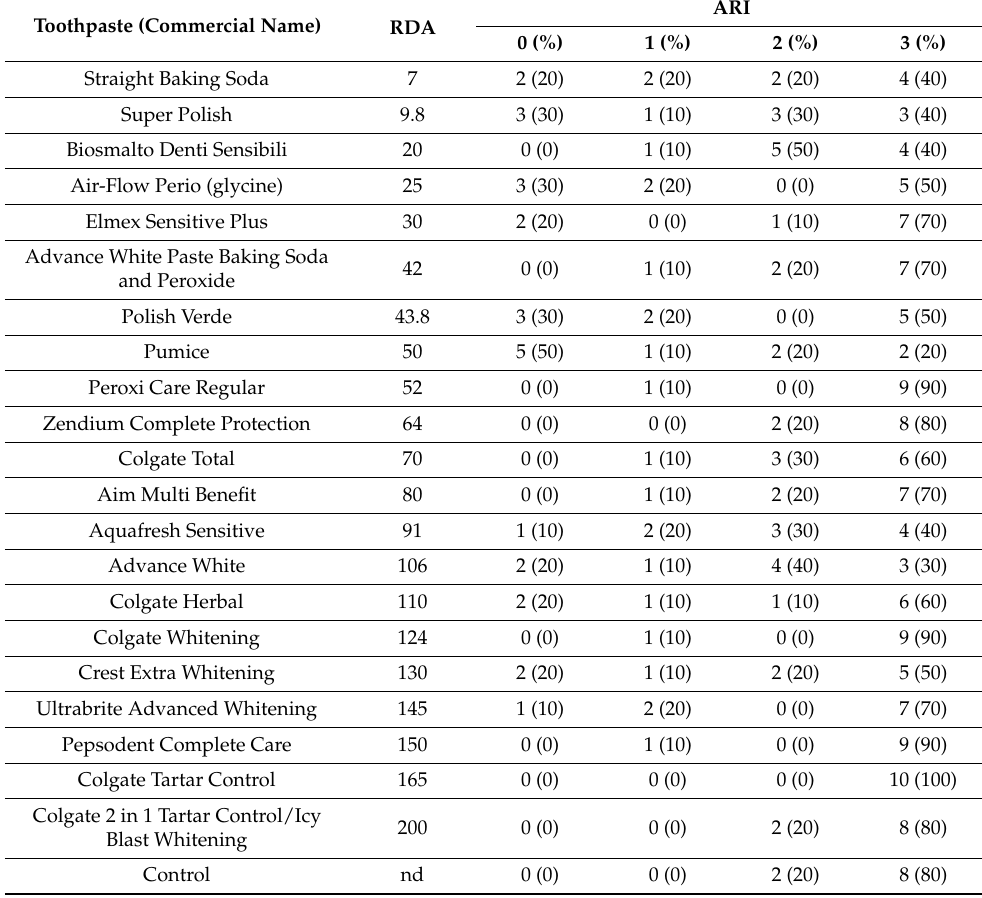
Table 5. RDA and ARI values.